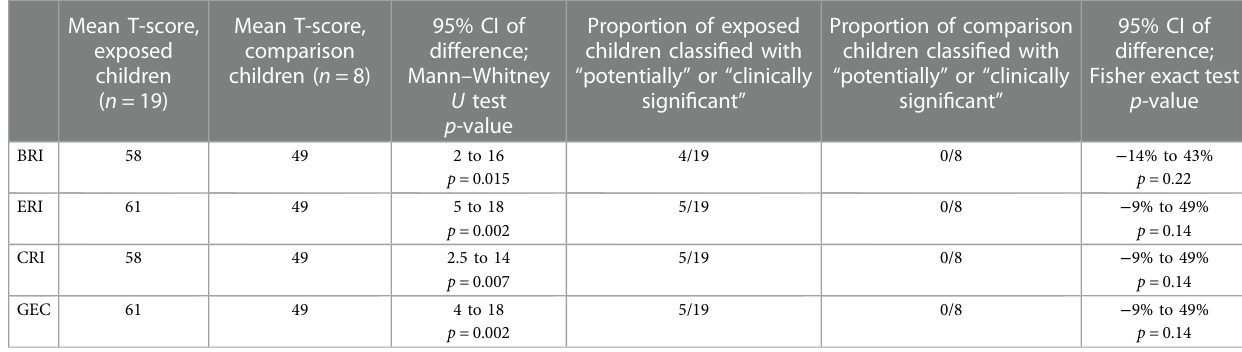
TABLE 4 BRIEF ® 2 results.